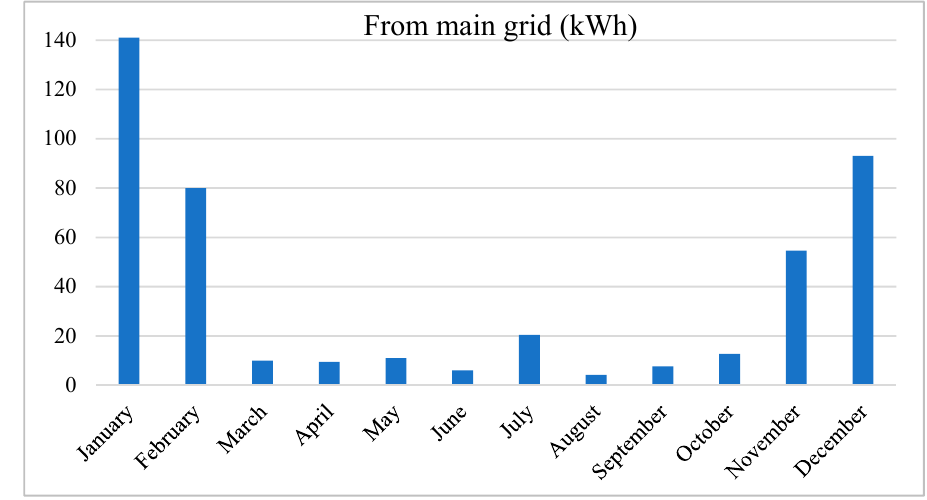
Figure 14. Total energy from the main grid per month in 2019.